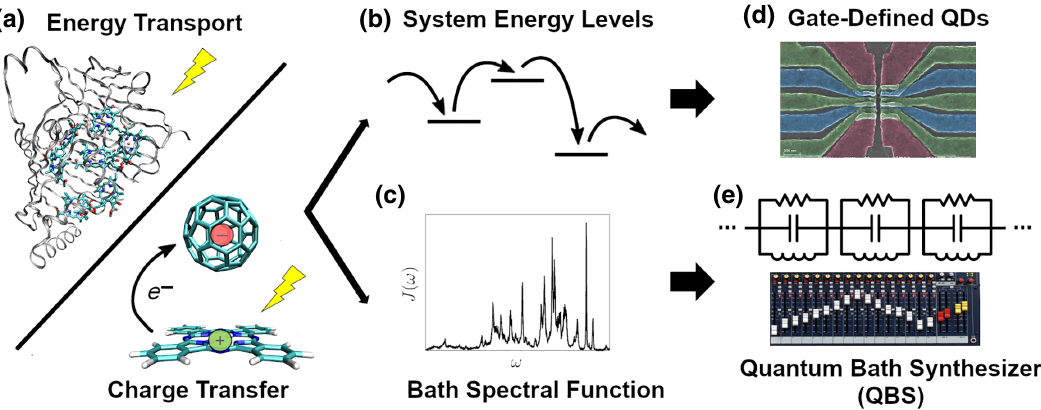
FIG. 1. Schematic of the proposed quantum simulator of open quantum systems based on quantum dots (QDs) and microelectronic circuits. The proposed setup is versatile enough to capture environments of chemical complexity such as those relevant in (a) energy transport in photosynthetic complexes and charge transfer in solar cells. The (b) system energy levels and (c) spectral density of the thermal environment are mapped into (d) gate-defined QDs and (e) a quantum bath synthesizer (QBS) composed of arrays of RLC